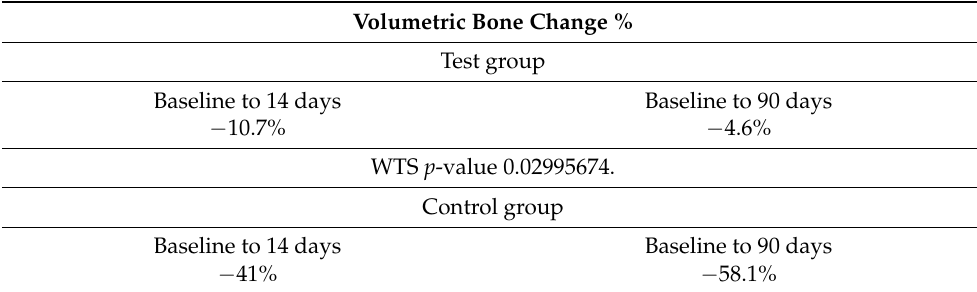
Table 1. Percentage volumetric bone remodeling in both groups and WTS p -value.